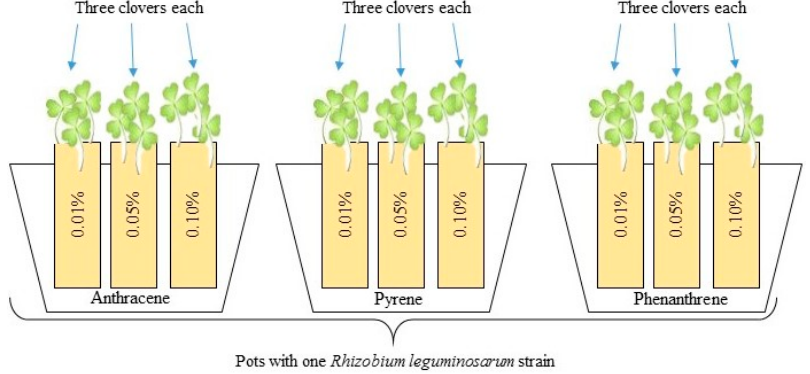
Figure 2. Scheme of biotest: each strain of Rhizobium leguminosarum was prepared with three pots, each containing sand contaminated with PAHs in three doses. Such pots were prepared in two repetitions—the second one was additionally co-inoculated with Azospirillum brasilense ; three clovers were growing in each pot.